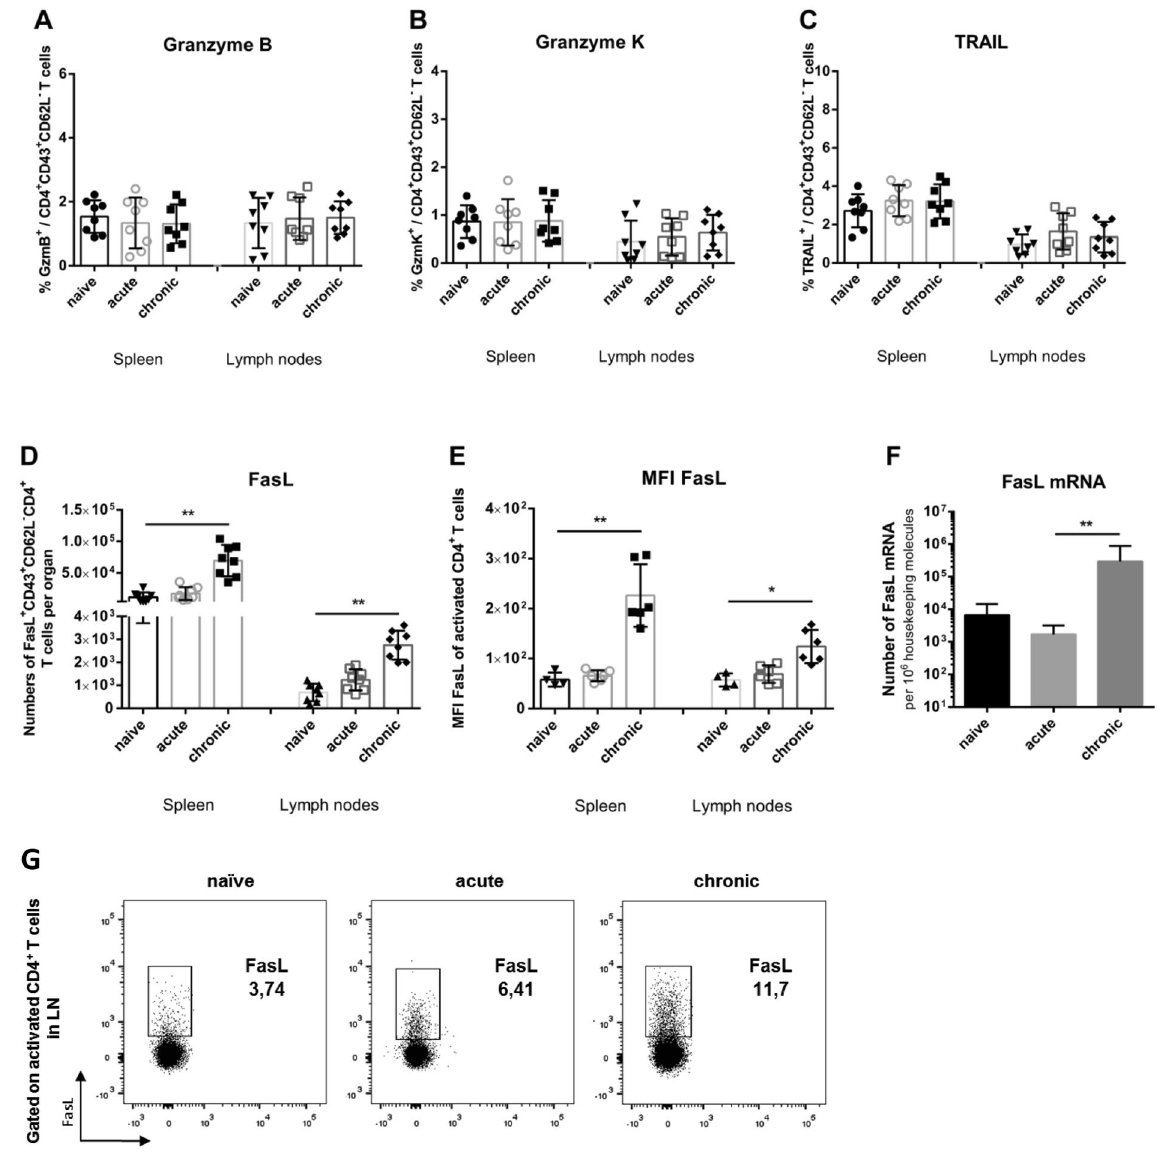
Figure 3. Expression of cytotoxic molecules in effector CD4 + T cells from chronically FV infected mice. Flow cytometry was used to detect intracellular granzymes, or surface Fas ligand in activated effector CD4 + T cells (CD43 + CD62L − ). ( A ) Percentages of effector CD4 + T cells expressing granzyme B. ( B ) Percentages of effector CD4 + T cells expressing granzyme K. ( C ) Percentages of effector CD4 + T cells expressing TRAIL after restimulation with α CD3 and α CD28 antibodies in vitro . ( D ) Absolute numbers of effector CD4 + T cells expressing FasL after restimulation with α CD3 and α CD28 antibodies in vitro . ( E ) FasL expression is presented as in D), except that data are expressed as MFI. ( F ) mRNA levels for FasL in effector CD4 + T cells isolated from FV infected mice. β -actin was used as an internal standard. ( G ) Representative dot plots of FasL expression on activated CD4 + T cells from different phases of FV infection. Each dot represents an individual mouse. Mean values are indicated by a line. Statistically significant differences between the groups were determined by the unpaired t test: * p < 0.05; ** p < 0.005. Data were pooled from at least two independent